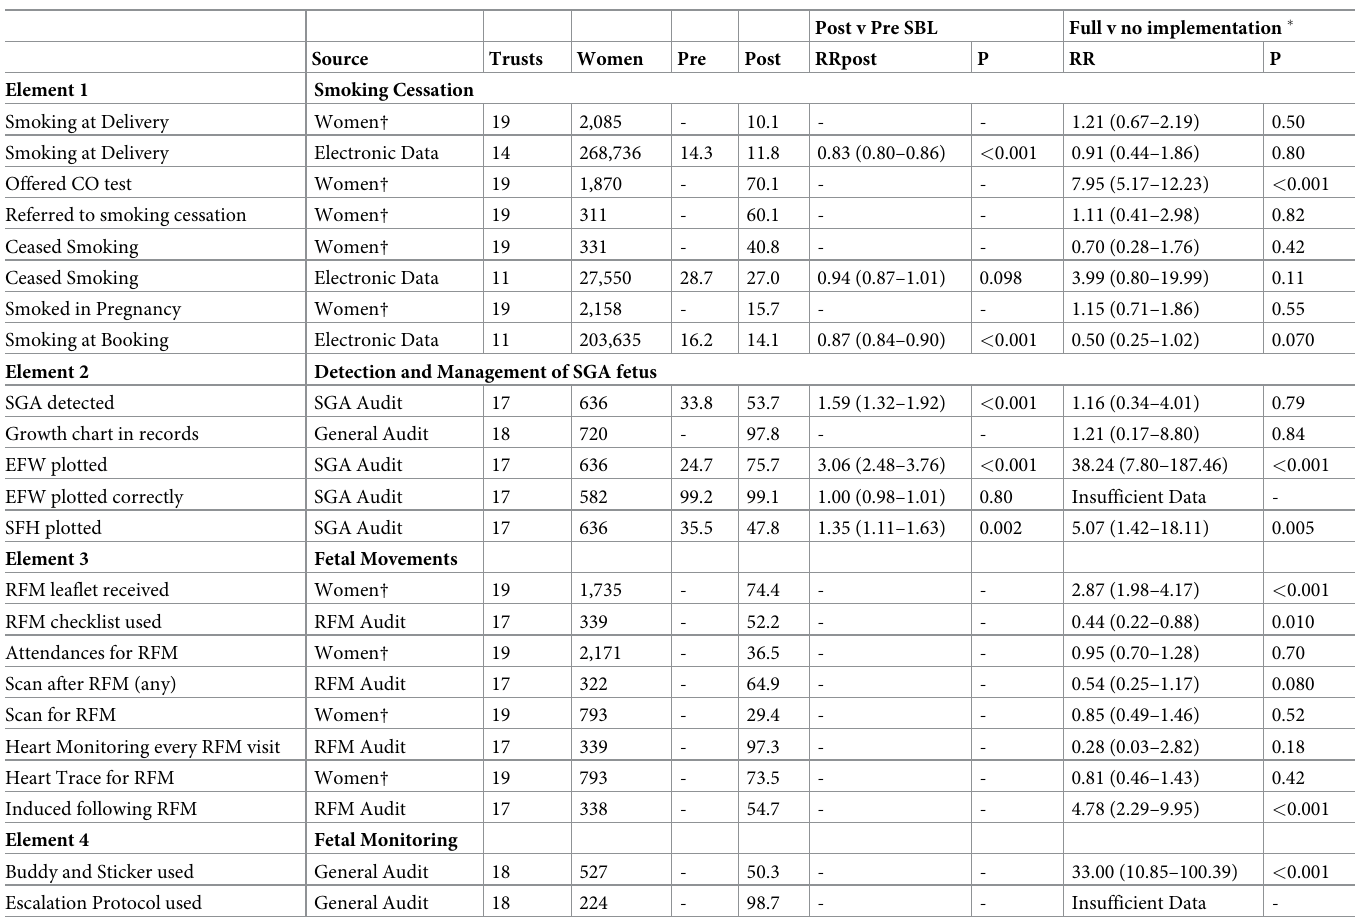
Table 3. Process